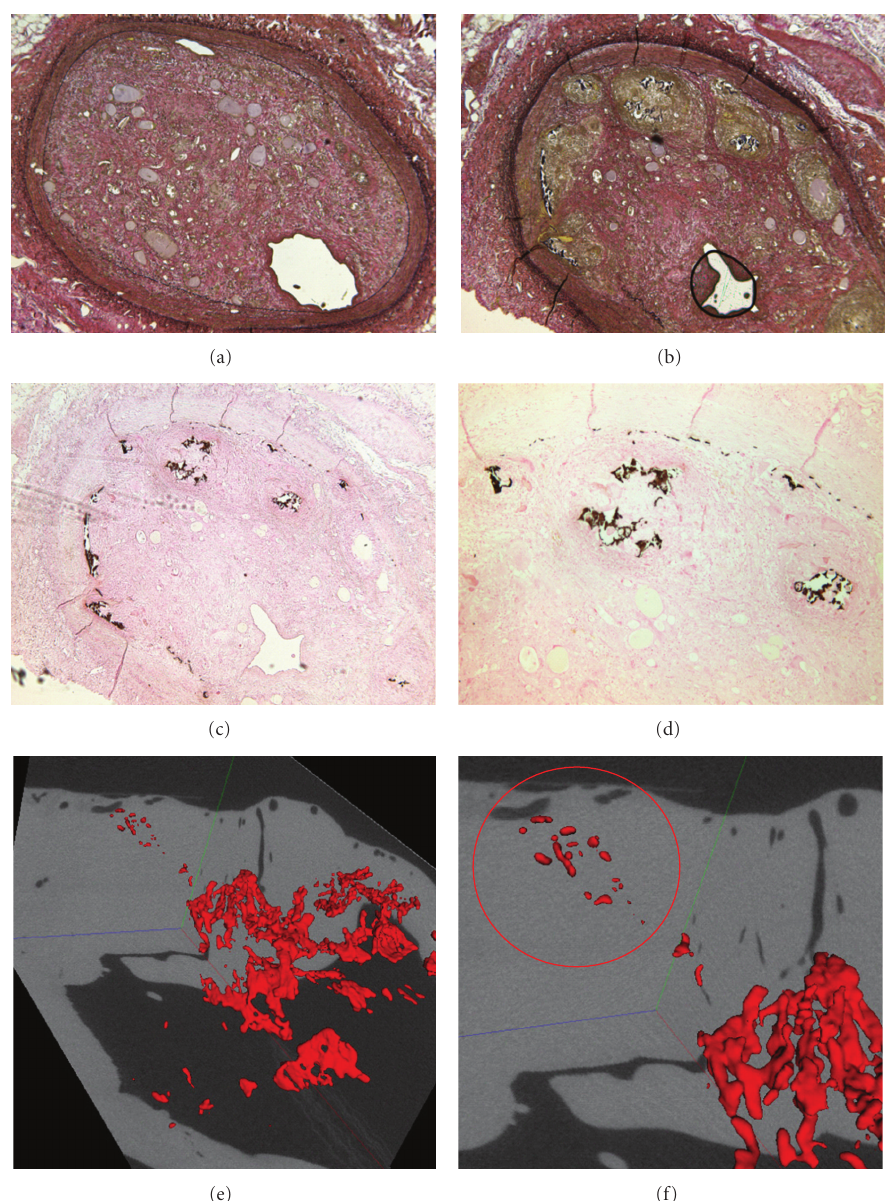
Figure 7: Histological examinations of pig experiments. Elastic-van Gieson (a, b) and Von kossa (c, d) stained CTO segment of coronary arteries. Arrows in (c) and (d) indicate microcalcification. Ex vivo micro-CT confirms that CTO lesions contain calcification in LAD (red circle)